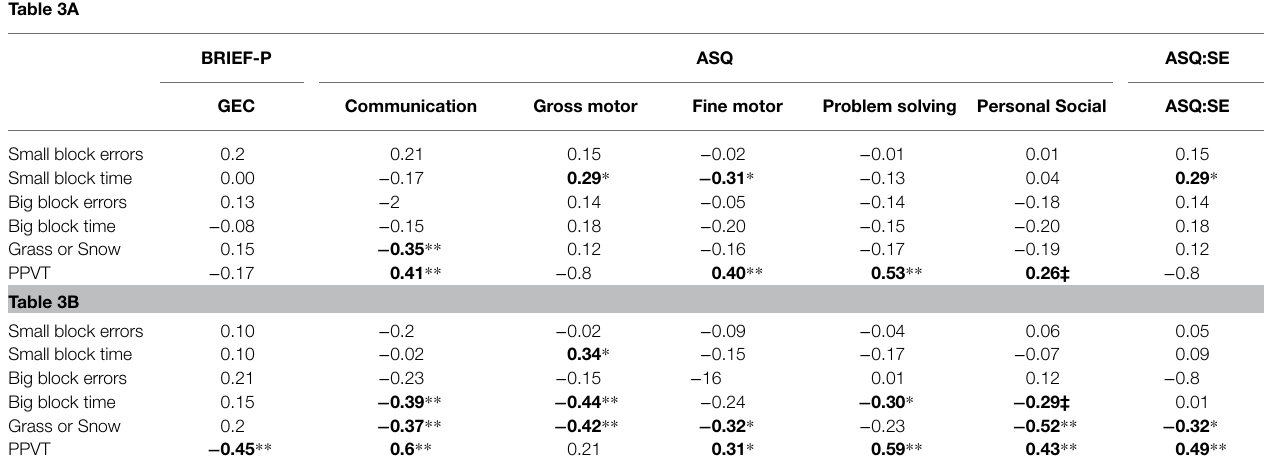
Bolded values are significant at these levels; * p < 0.05. ** p < 0.01. ‡ p <